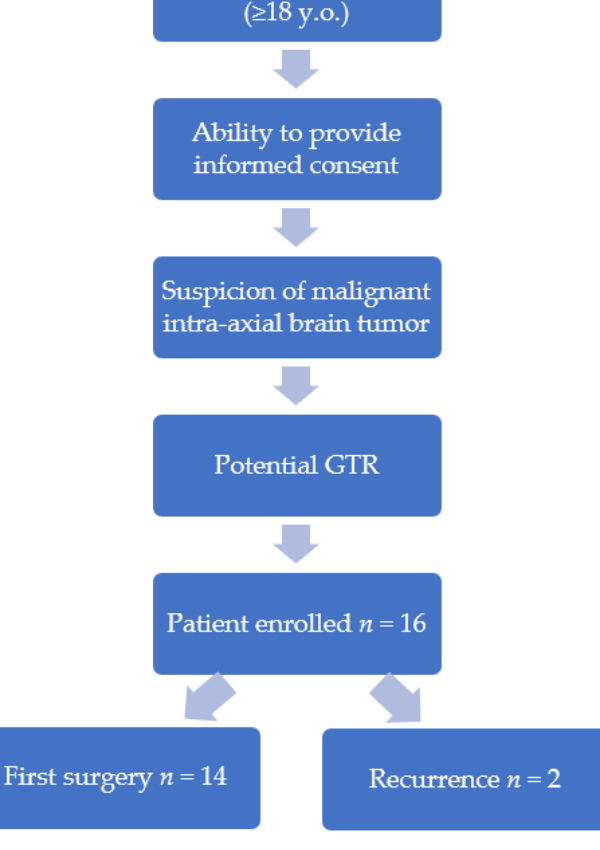
Figure 1. Flow chart designed for patient enrollment.